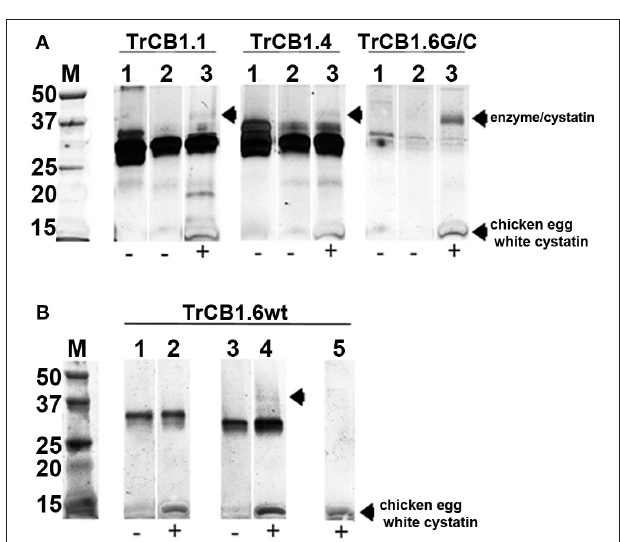
FIGURE 8 | Complex formation between TrCB1 forms and chicken egg white cystatin monitored by SDS-PAGE. (A) Auto-activated dsTrCB1.1, dsTrCB1.4, dsTrCB1.6G/C after overnight incubation at 4 ◦ C in the presence/absence of chicken egg white cystatin. After incubation, the samples were mixed with non-reducing sample buffer and resolved by SDS-PAGE. Proteins were visualized by silver staining. (1) pro-TrCB1, (2) dsTrCB1 without cystatin, (3) dsTrCB1 with cystatin. Note the autodegradation of TrCB1.6G/C (lanes 1 to 3) happening during incubation, resulting in weak protein bands. (B) pepTrCB1.6wt after overnight incubation at 4 ◦ C in the presence/absence of cystatin. (1) pro-TrCB1.6wt, (2) pro-TrCB1.6wt with cystatin, (3) pepTrCB1.6wt, (4) pepTrCB1.6wt with cystatin, (5) control lane with cystatin only. Arrows point to peptidase/cystatin complex and/or to cystatin (in section B, lane 5). M, markers of molecular size